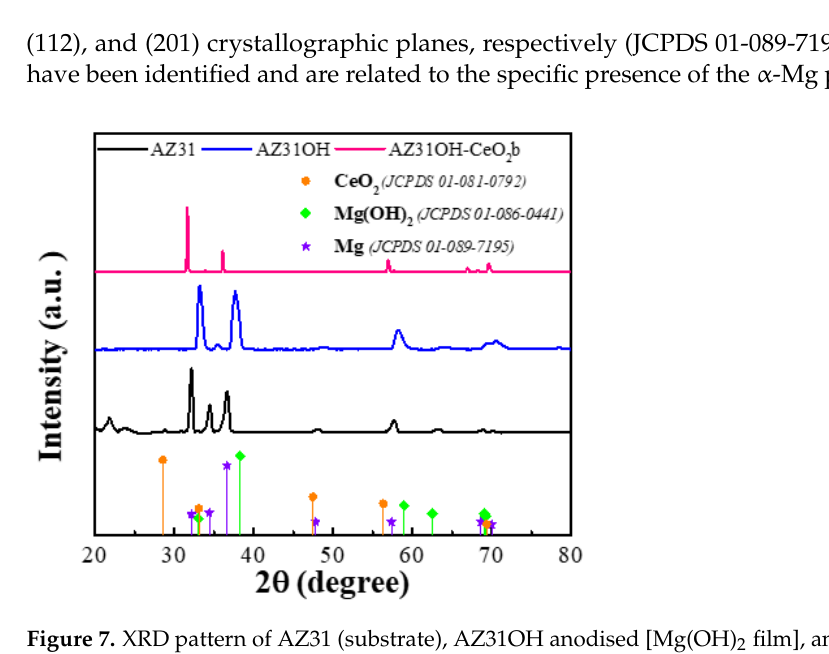
Figure 7. XRD pattern of AZ31 (substrate), AZ31OH anodised [Mg(OH) 2 film], and AZ31OH-CeO 2 , cerium coating.